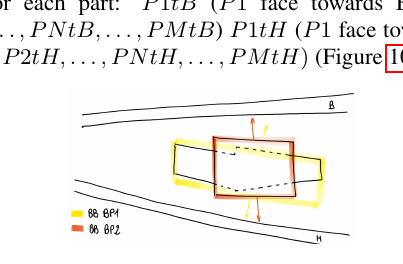
Figure 10. BP 1 and BP 2 bounding boxes, normals and